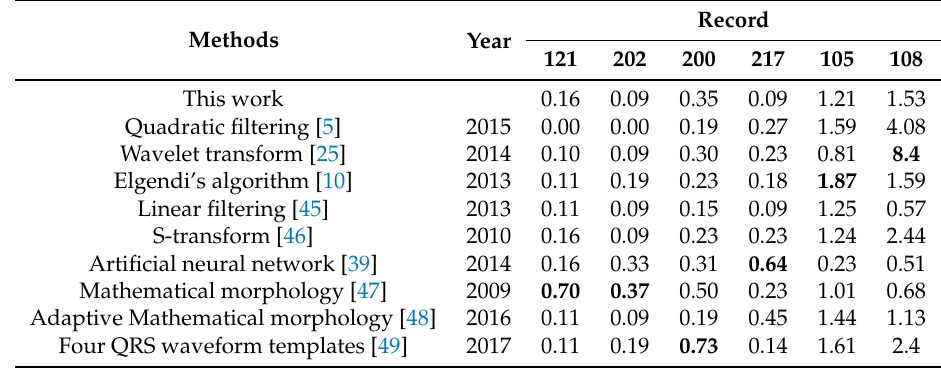
Table 6. Comparisons of the DER from the proposed method with other studies for ECG records 121, 200, 202, 217, 105, and